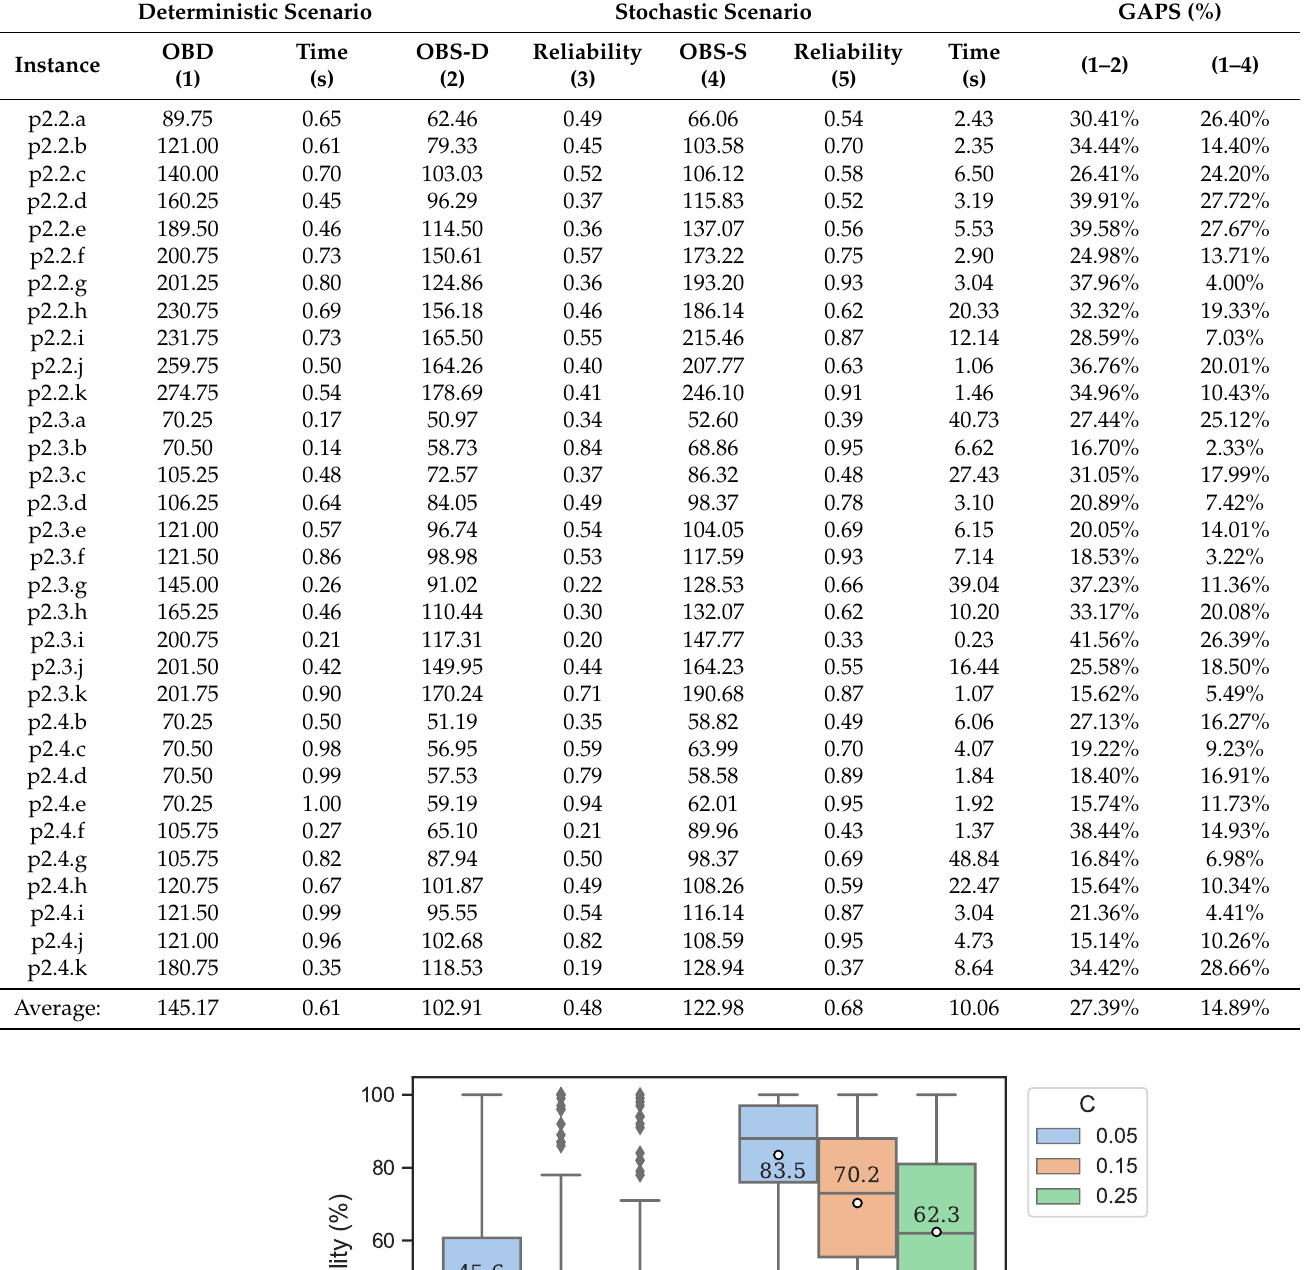
Table 7. Results for p 2 instances in a stochastic scenario with a high variance ( c = 0.25).